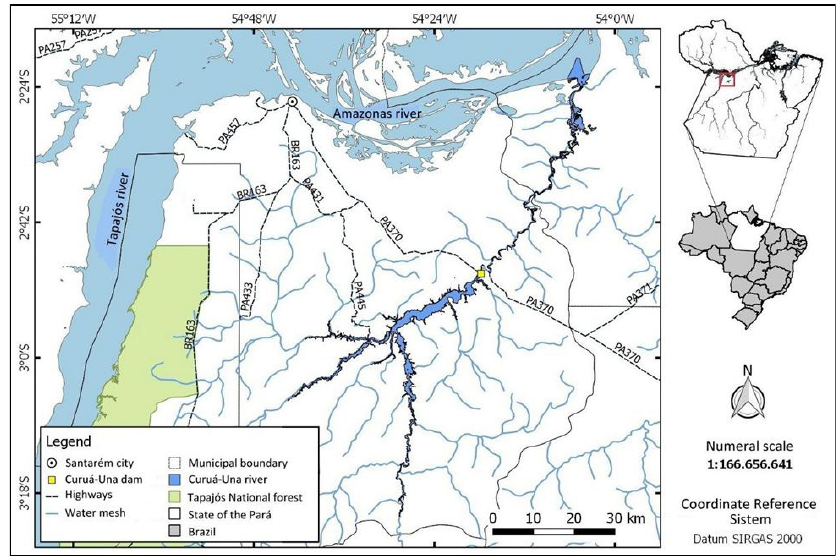
Figure 1. Geographical location of the Curuá-Una HPP, near the city of Santarém in Pará. Source: Water Geoinformation Laboratory – LAGIS.